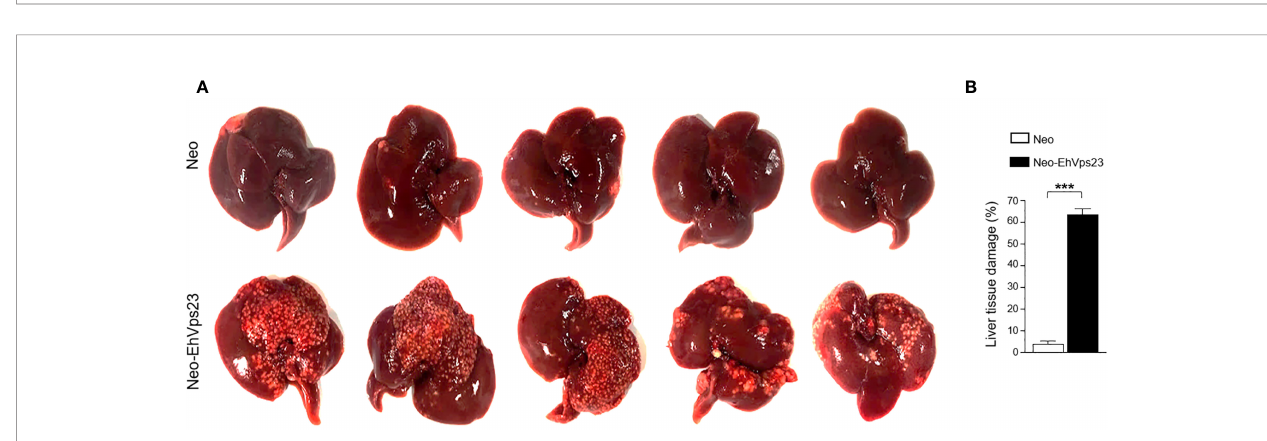
FIGURE 10 | Livers of hamsters intraportally inoculated with Neo and Neo-EhVps23 trophozoites. (A) Animals under anesthesia were inoculated with Neo or Neo-EhVps23 trophozoites. Six days later, trophozoites were anesthetized and livers were extracted to examine the damage produced by the trophozoites. (B) Percentage of the damage was calculated by weighting the livers, weighting the damage tissue and obtaining the relation between them. ***P <